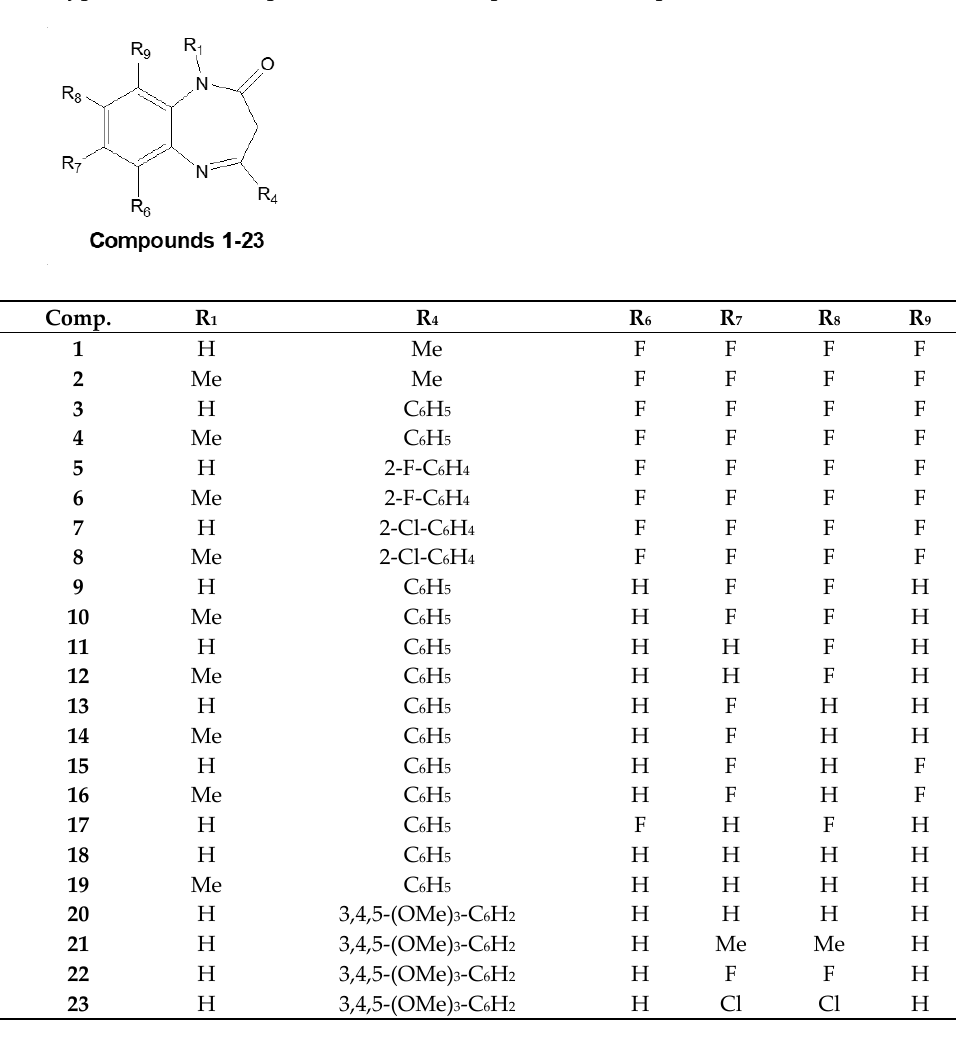
Figure 2. The studied 1,5-benzodiazepin2-(3 H )-ones.